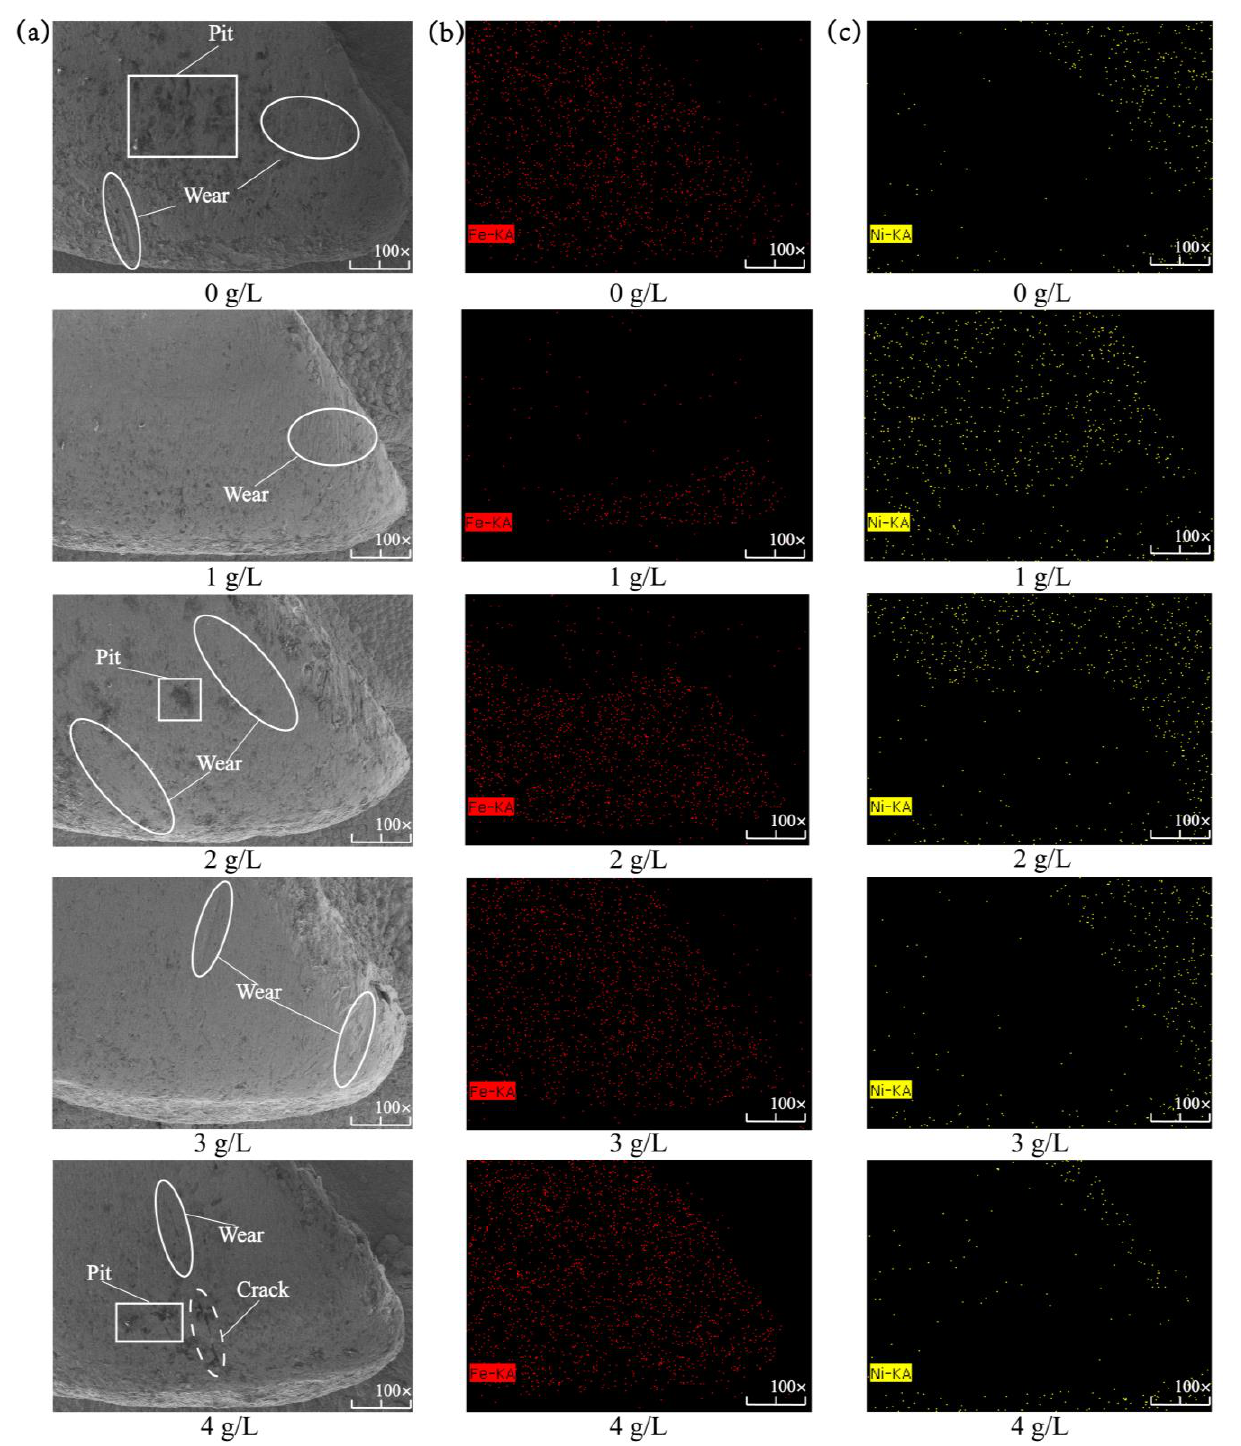
Figure 9. Microstructure and EDS spectroscopic analysis of the composite coating with different concentrations of β -SiC nanoparticles prepared on the surface of the spindle hook teeth after simulated wear: ( a ) microstructure, ( b ) scanning on the surface of the spindle hook tooth of Fe, and ( c ) scanning on the surface of the spindle hook tooth of Ni.